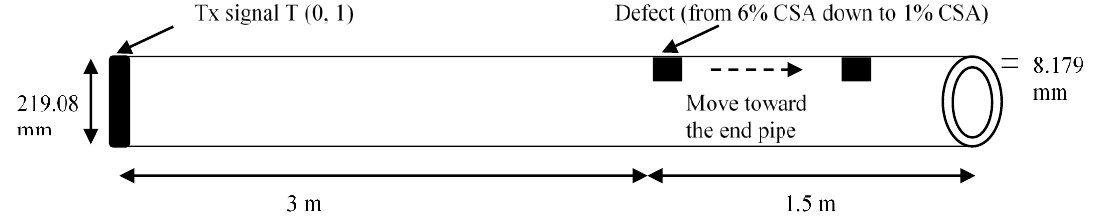
Figure 4. Synthesised setup for an eight inch pipe with a wall thickness of 8.179 mm and an outside diameter of 219.08 mm.